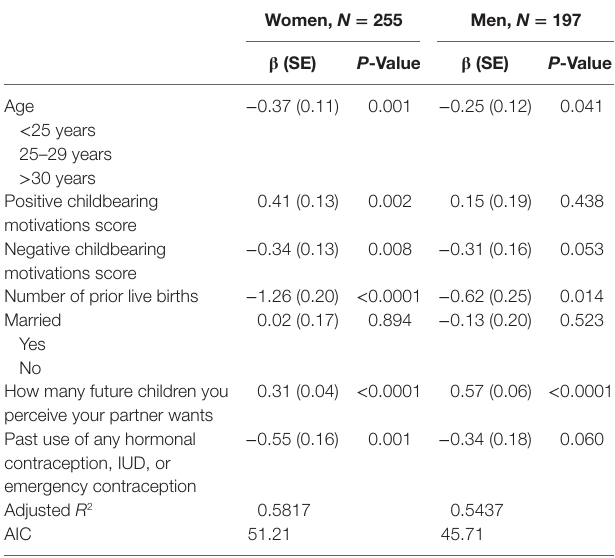
TaBle 6 | Factors associated with number of children wanted in the future in women and men.